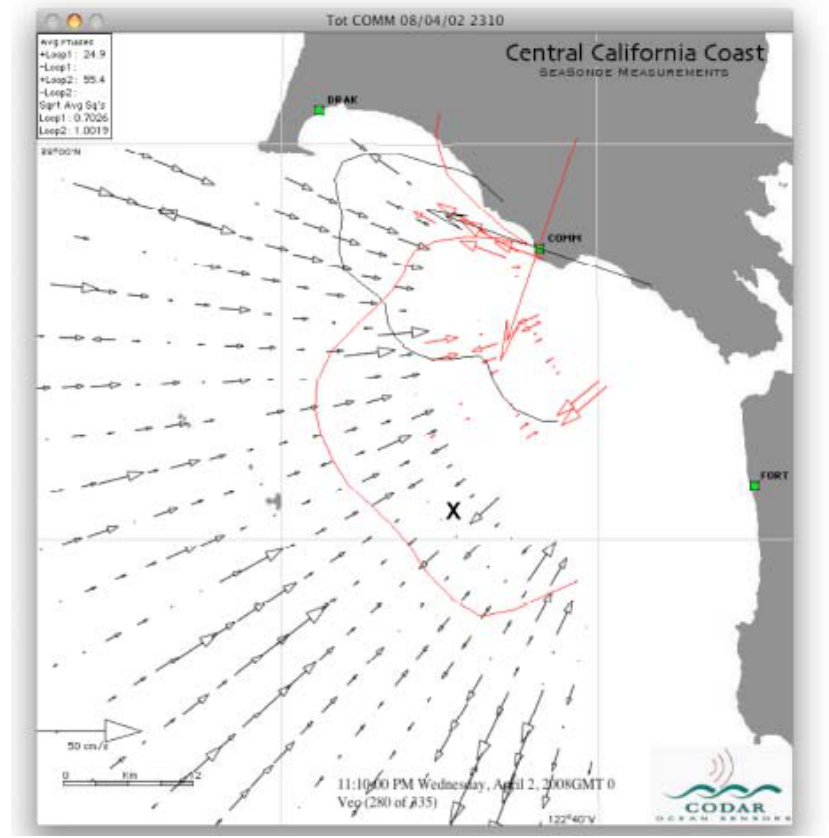
Figure 12. A comparison map of elliptical velocities, measured by COMM (Black) and drifters (Red) on April 02, 2008, 23:10. Time series of elliptical velocities at the point shown marked X are plotted in Figure 13. Normalized radar antenna patterns are shown: Loop 1 (black) ; Loop 2 (red).